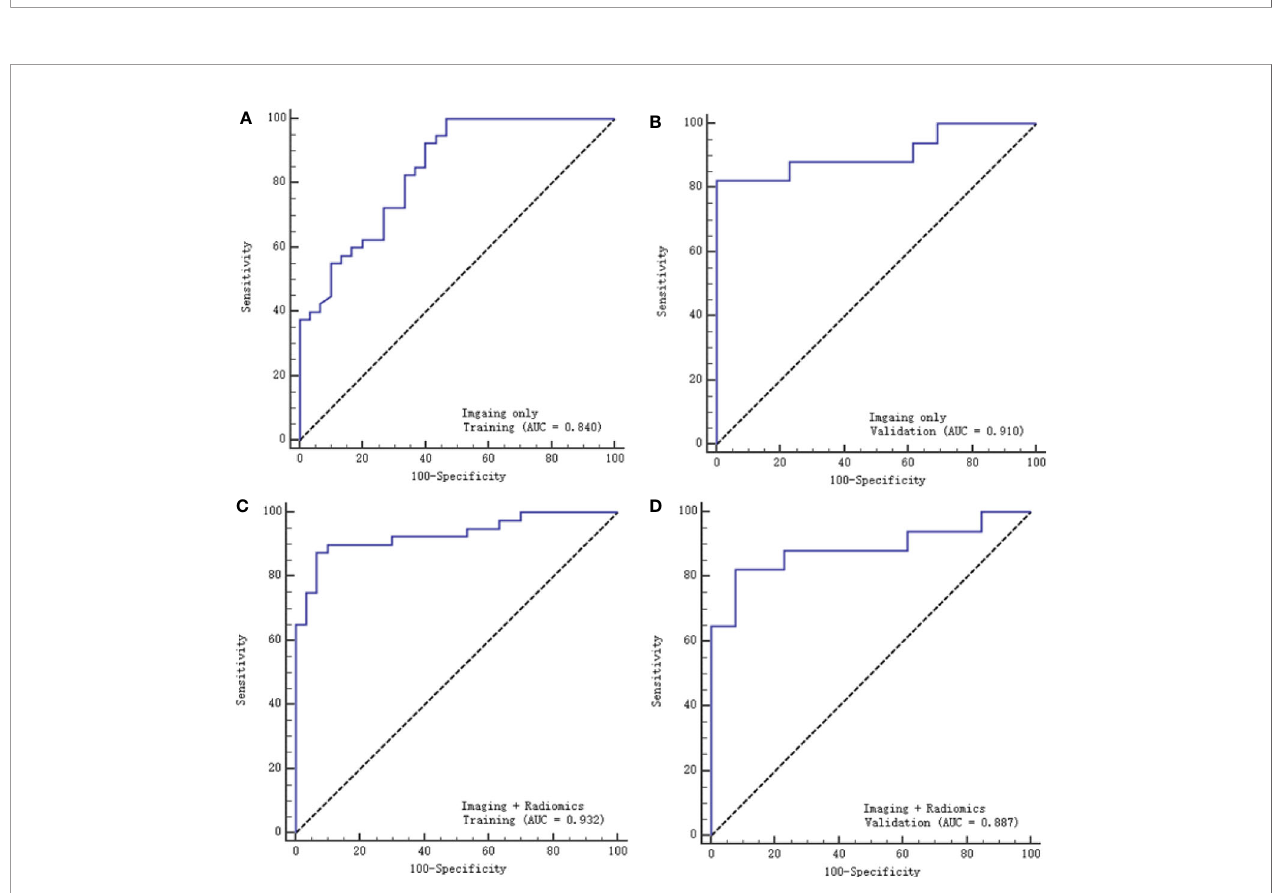
FIGURE 6 | ROC curves of the two models with the training and validation cohorts. (A, B) represent the imaging model alone, respectively, and (C, D) represent the imaging and radiomics